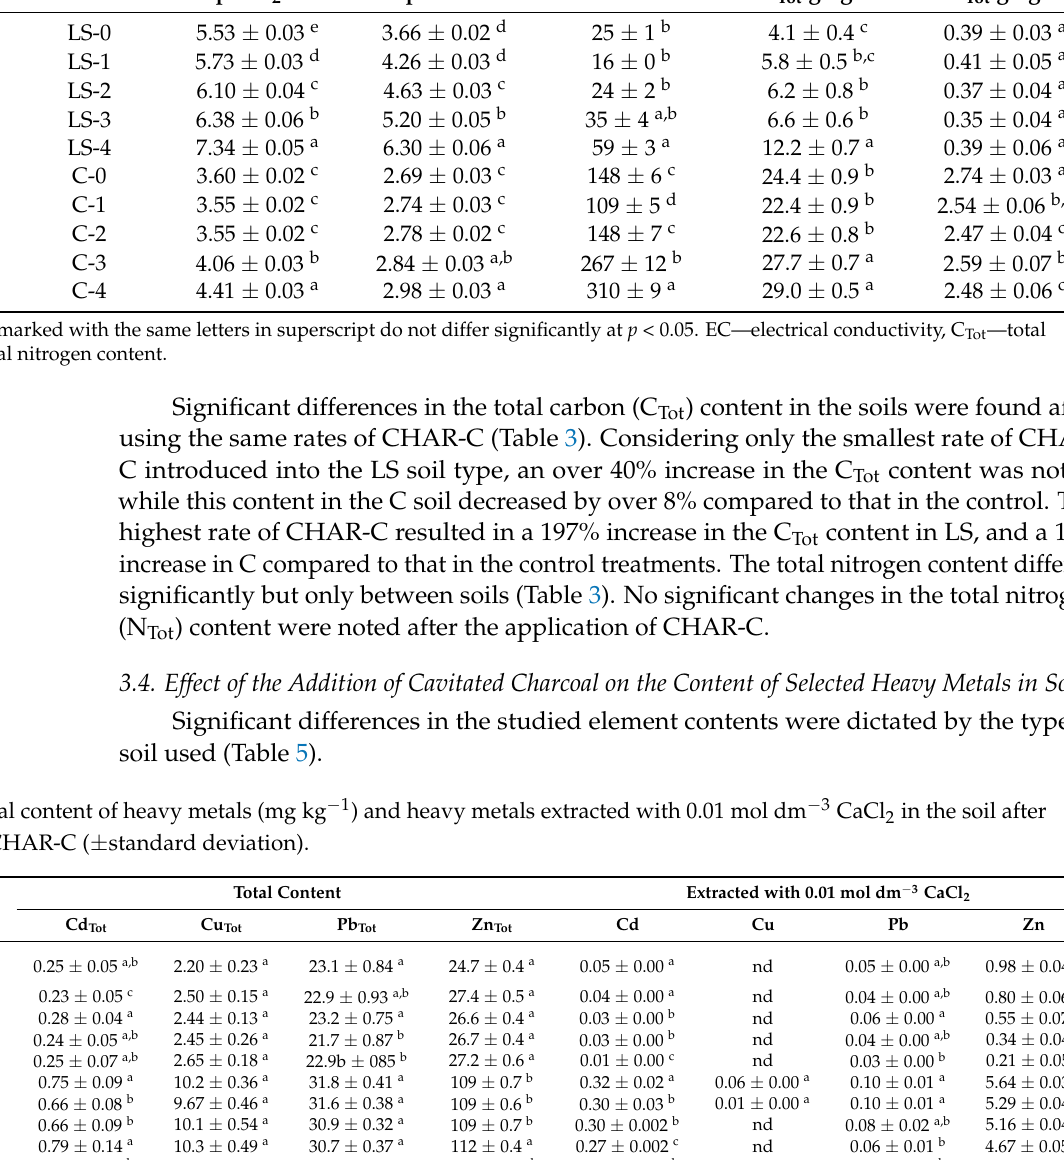
Table 4. Chemical properties of the soil after application of CHAR-C ( ± standard deviation).